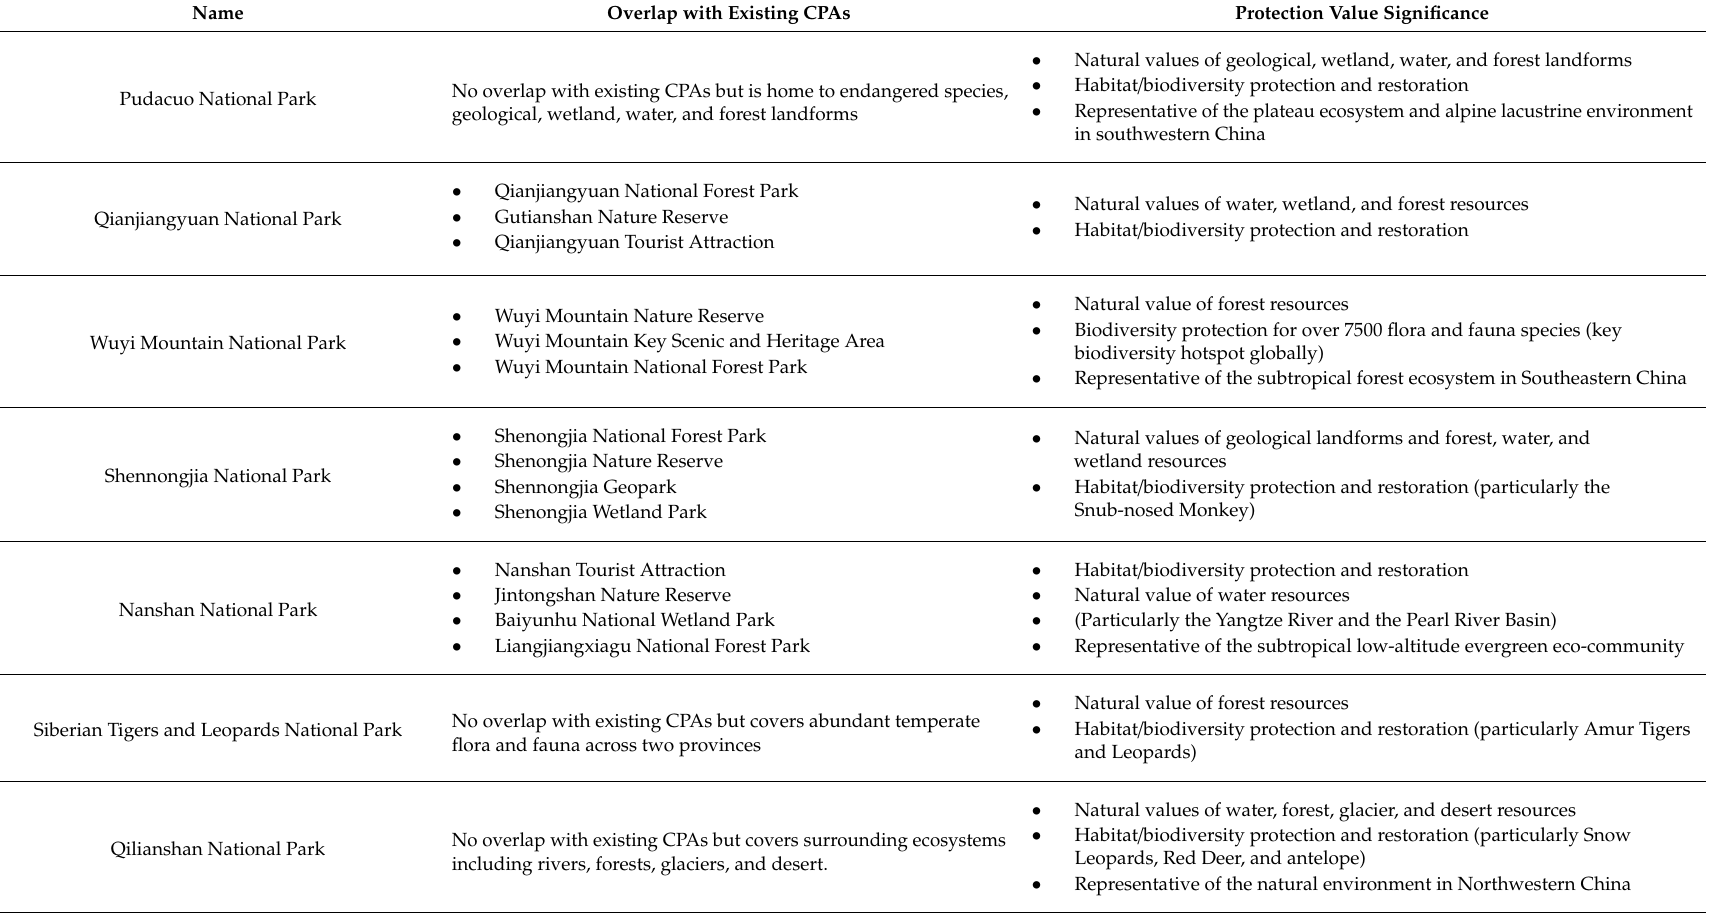
Table 4. Profile of ten pilot national parks in